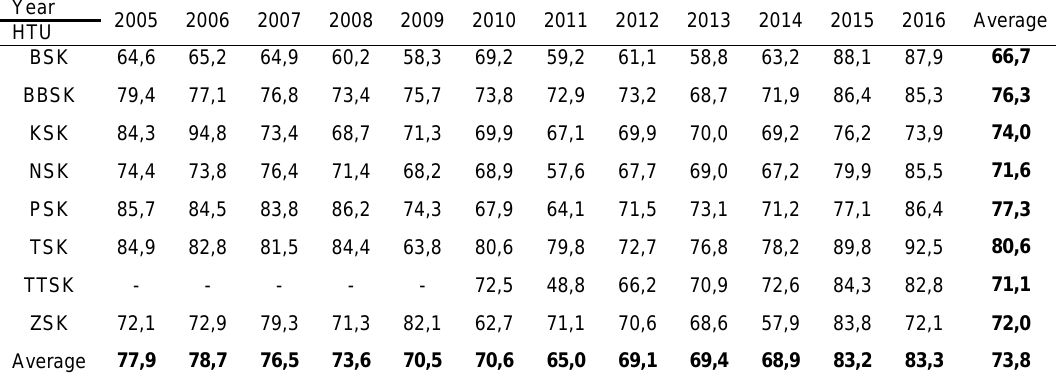
Table 3. The rate of financial dependence of HTUs during the years 2005-2016